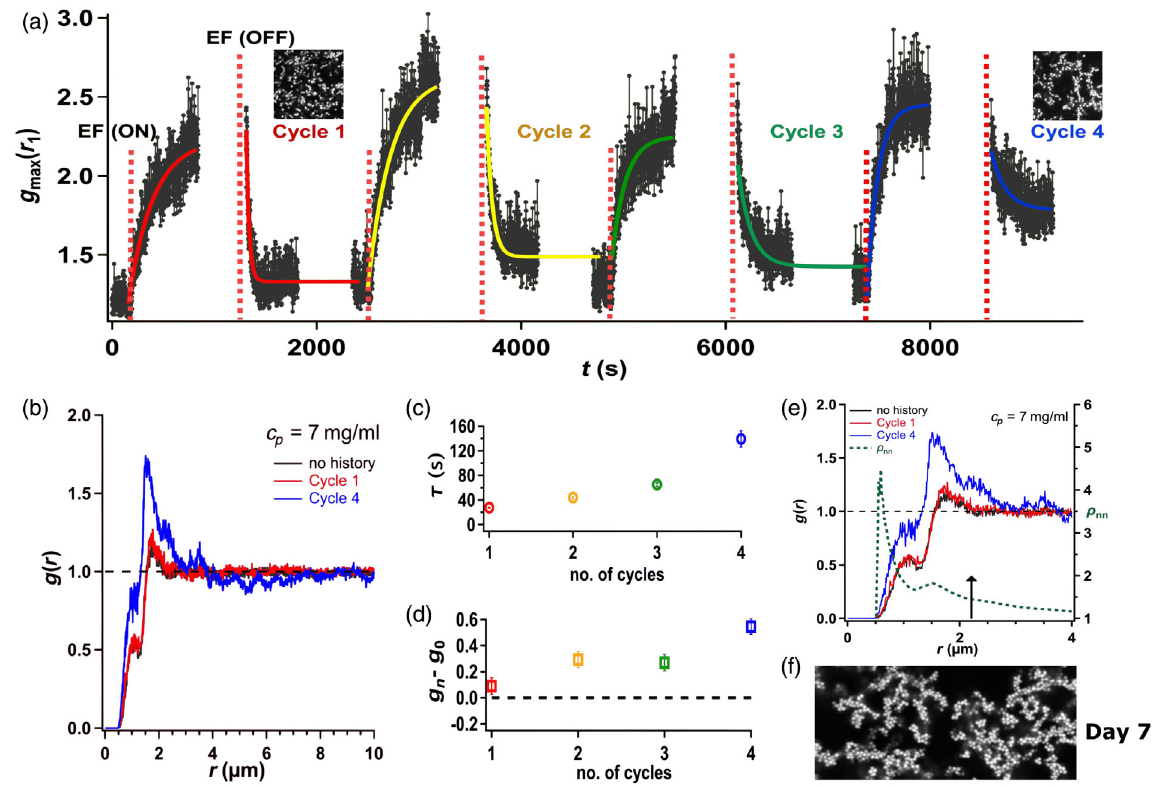
¼ 7 mg = ml to probe reversibility by repeating experiments multiple times. Exponential FIG. 5. Accelerated aging. (a) Kinetics at c p fits to g ð r 1 Þ , as a function of time t , when the applied field is turned on [EF (ON)] and off [EF (OFF)], are shown in red for cycle 1 and yellow, green, and blue for subsequent cycles. (b) The first peak of g ð r Þ for cycle 4 increases substantially as compared to no history and cycle 1 reflecting clusters that persist for long times after turning off the field. (c) The decay time ( τ ) for colloidal structures to − g disintegrate in each cycle to reach a steady state increases with the number of cycles. (d) A structural measure of reversibility g 0 n ð r Þ (green dashed line), the deviates further from zero with increasing number of cycles n . (e) g ð r Þ data from (b) are used to calculate ρ nn ratio, as a function of r , of the coordination number for cycle 4 and no history (dashed line). At the minimum following the primary peak ð r Þ ≈ 1 . 6 . (f) 2D image ( 256 × 120 pixels) of the same sample captured on day of g ð r Þ ( r ¼ 2 . 2 μ m, indicated by the vertical arrow), ρ nn 7 and averaged over a timescale of 13.5 s shows immobility in the network of